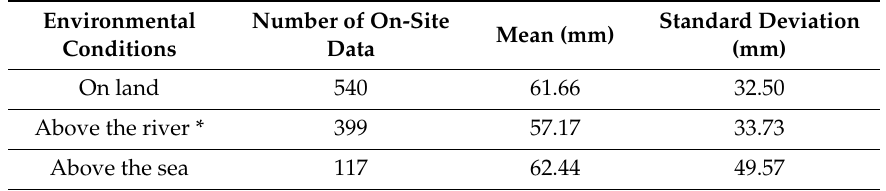
Table 4. Statistical data of concrete cover thickness of subject bridges according to environmental Table4. conditions.